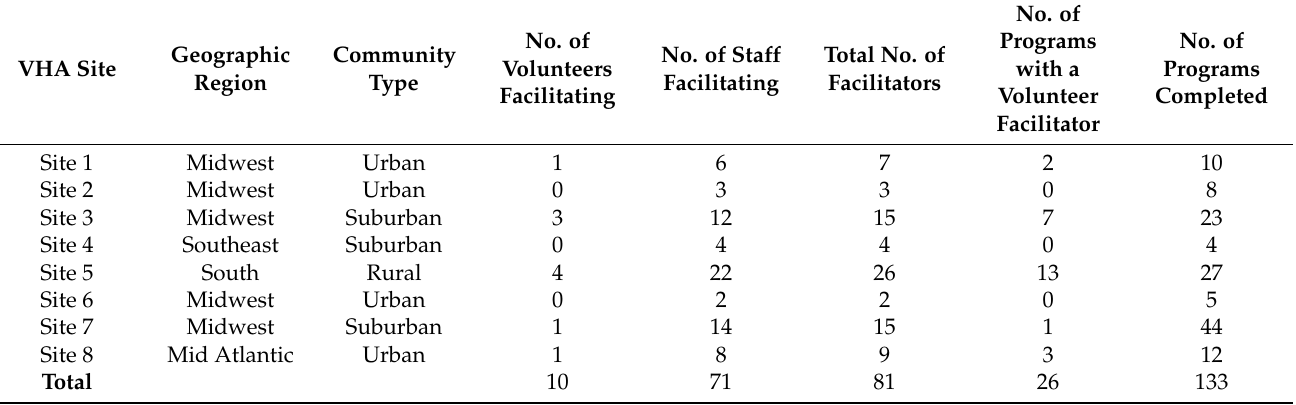
Table 3. Description and TCMLH Staffing by Site, FY2016-2018 Quarterly Site